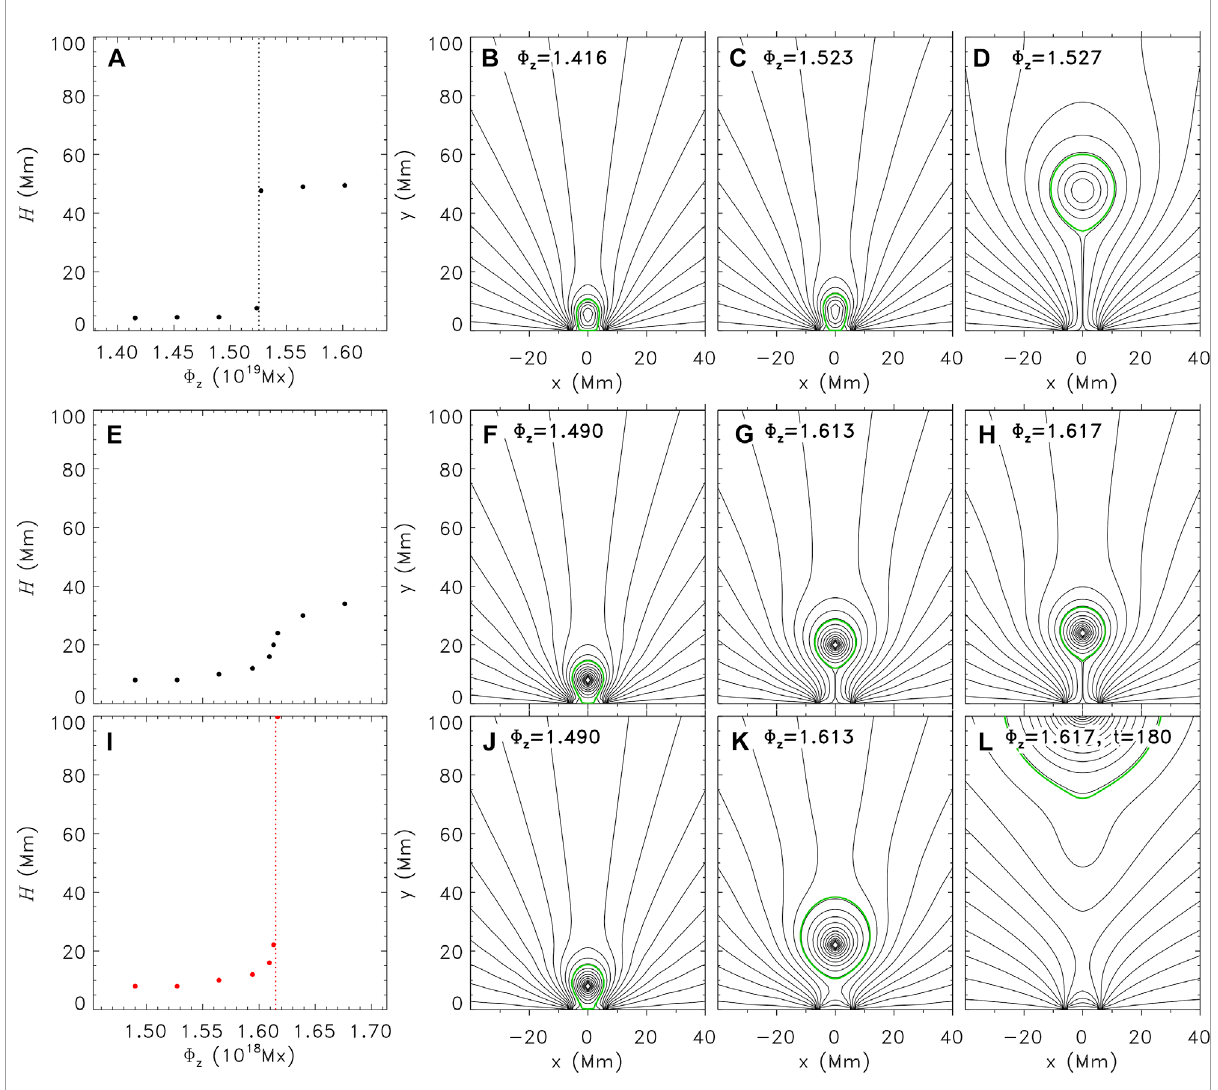
FIGURE 2 The simulation results for Case I and Case II. Panel (A) is the equilibrium manifold for Case I under the ideal MHD condition; panels (B–D) are the magnetic configuration of the simulated equilibrium states for Case I, and the corresponding Φ z is marked at the top of each panel. Panels (E–H) and panels (I– (L) are the simulation results for Case II under the ideal MHD and the resistive condition, respectively; the red vertical dotted line in panel (I) denote the catastrophic point Φ w zc . The green curves mark the boundary of the flux